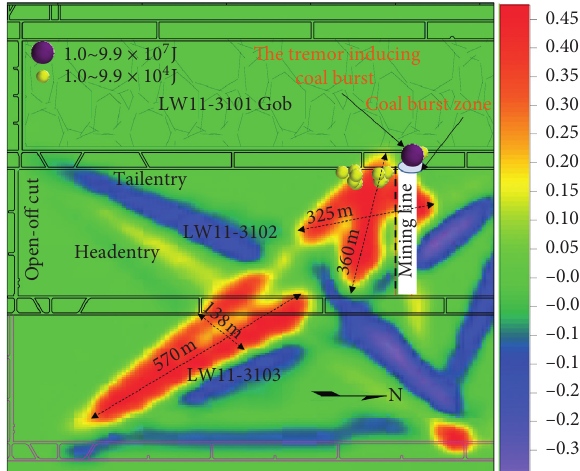
Figure 11: Tomography results between 1 February and 3 March, 2018, in